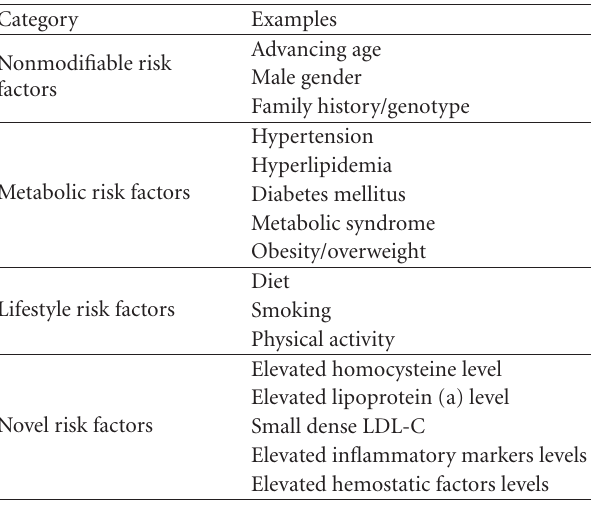
Table 1: Cardiovascular risk